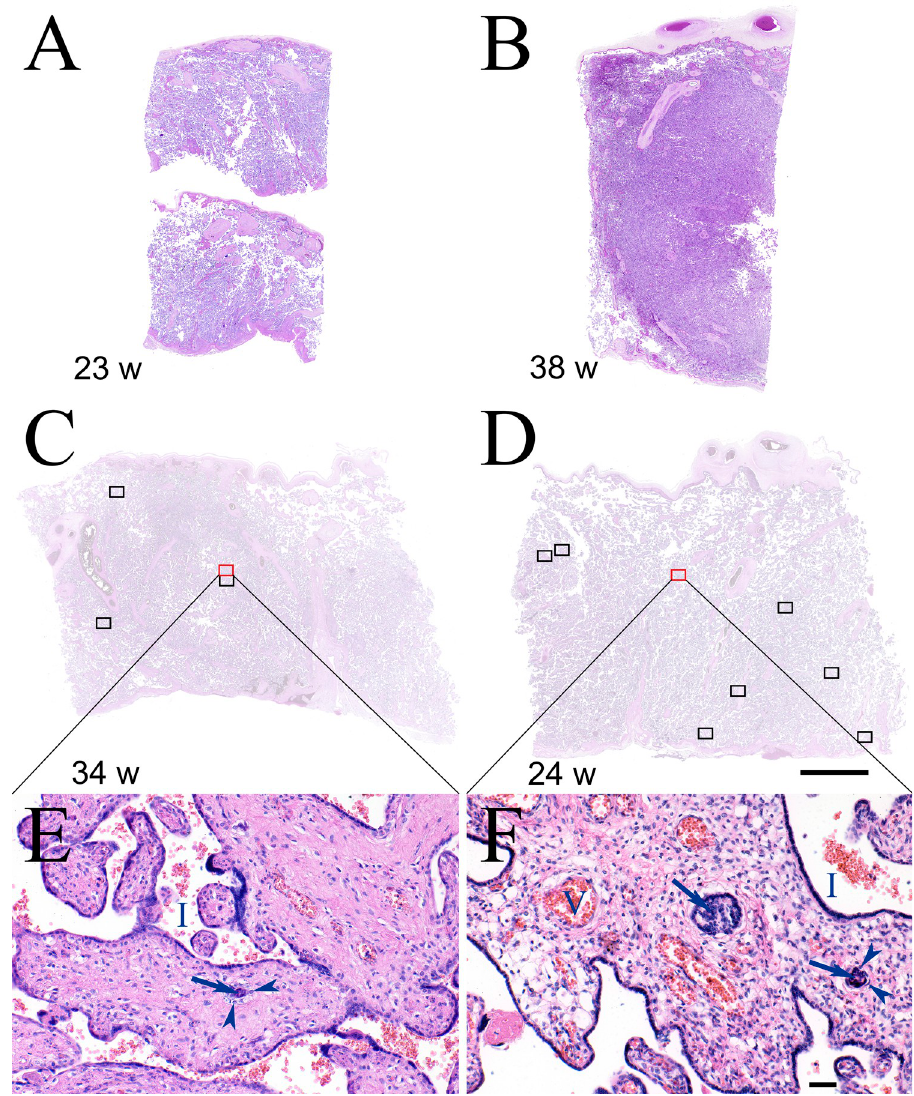
Fig 1. Representative villi from none, mild and marked TI categories. A) A slide from a representative case at 23 weeks for which no TIs were identified. B) A slide from representative case at 38 weeks for which no TIs were identified. C) A slide from a representative case at 34 weeks that was in the ‘mild’ TI category. Four TIs were identified in this slide (indicated by rectangles) and an additional 3 TIs were identified in the second slide (not shown) from this case (average 3.5/slide = ‘mild’ category). The villi within the red rectangle are enlarged in panel E which demonstrates a single TI with central syncytiotrophoblast nuclei (arrow) surrounded by cytotrophoblasts (arrow heads). Intervillous space (I). D) A slide from a representative case at 24 weeks that was in the ‘marked’ TI category. Nine TIs were identified in this slide (indicated by rectangles) and an additional 10 TIs were identified in the second slide (not shown) from this case (average 9.5/slide = ‘marked’ category). The villi within the red rectangle are enlarged in panel F which demonstrates two TIs in one villus with central syncytiotrophoblast nuclei (arrows) surrounded by cytotrophoblasts (arrow heads). Intervillous space (I). Panels A-D are all at the same magnification, scale bar = 5 mm. Panels E and F are at the same magnification, scale bar = 50 μ